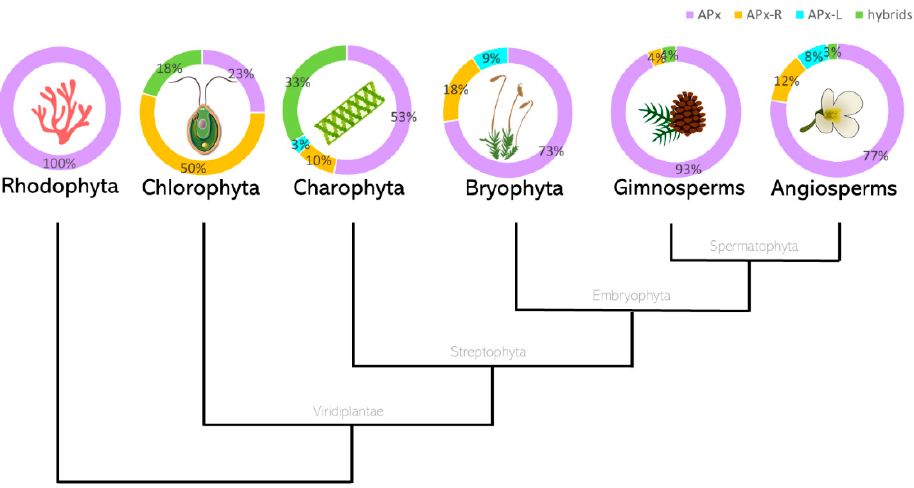
Figure 3. Protein sequences currently annotated in RedOxiBase were classified according to key residues as APX, APX-R, APX-L, or hybrids. The total number of sequences analyzed is 6, 22, 177, 11, 28, and 389, respectively. Each group of proteins is represented by the following colours: APX, purple; APX-R, orange; APX-L, cyan; and hybrids are shown in green. *The data presented for Charophytes include sequences currently annotated in RedOxiBase in addition to 147 assembled sequences obtained from transcriptomic data, available in Table S3.